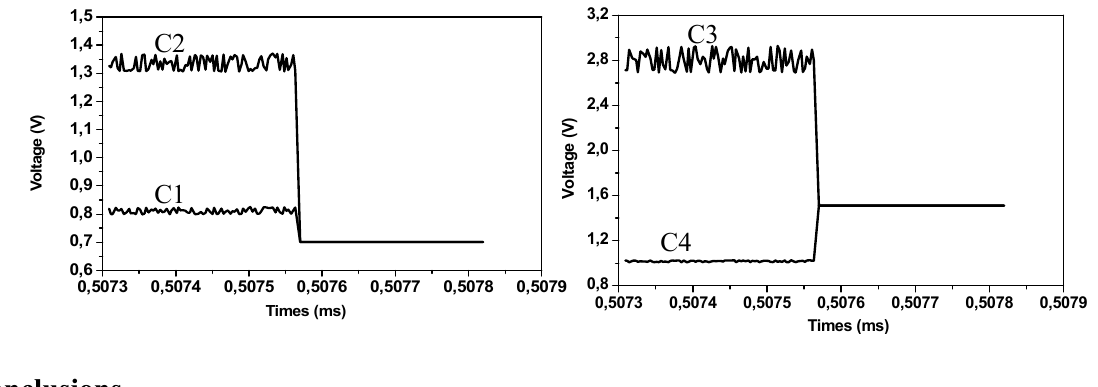
Figure 23. Voltage variation of the LDR sensor C1, C2, C3 and